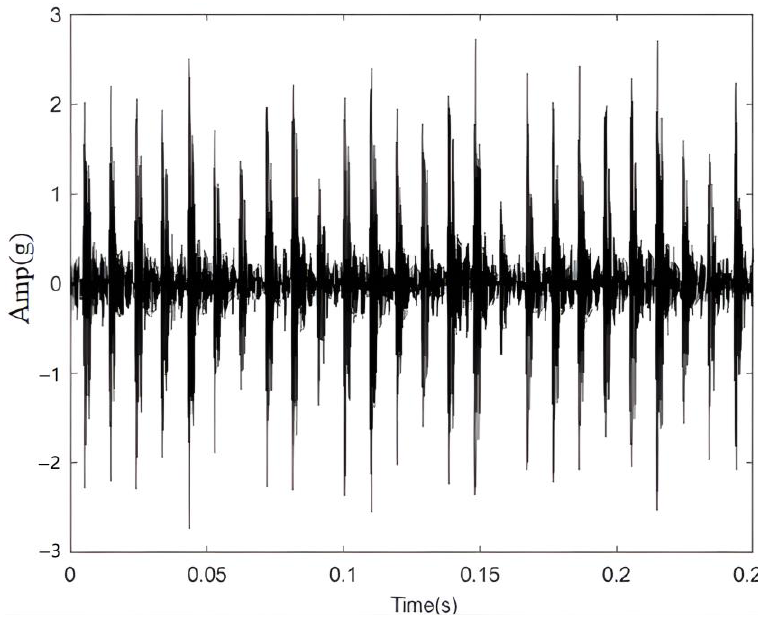
Figure 2. Time Domain Diagram of Outer Ring Fault Signal.